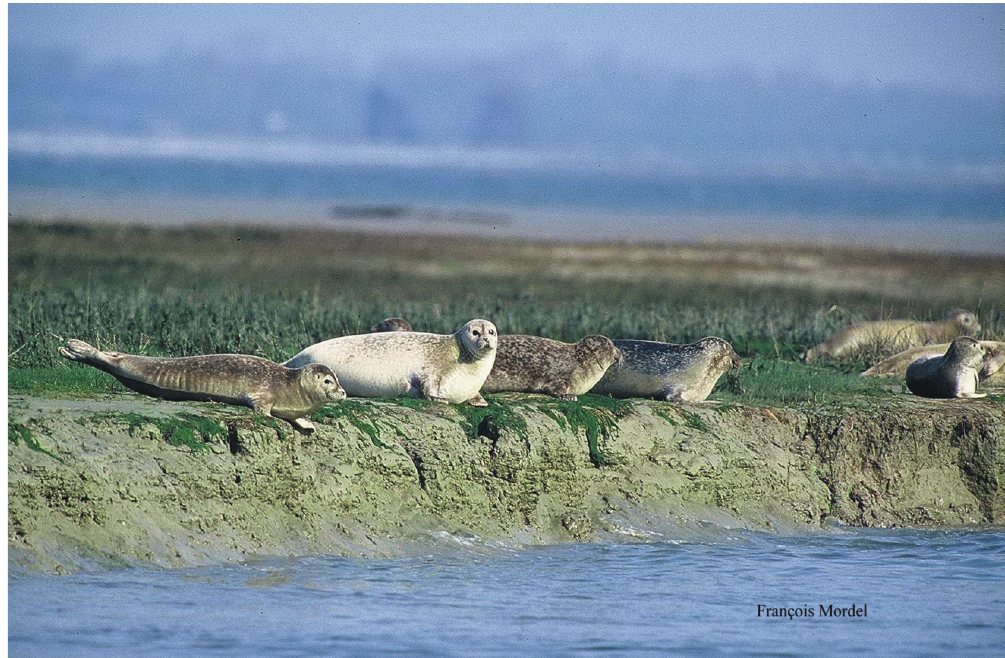
Fig. 2. Typical sandy harbour seal haulout habitat in France at Baie des